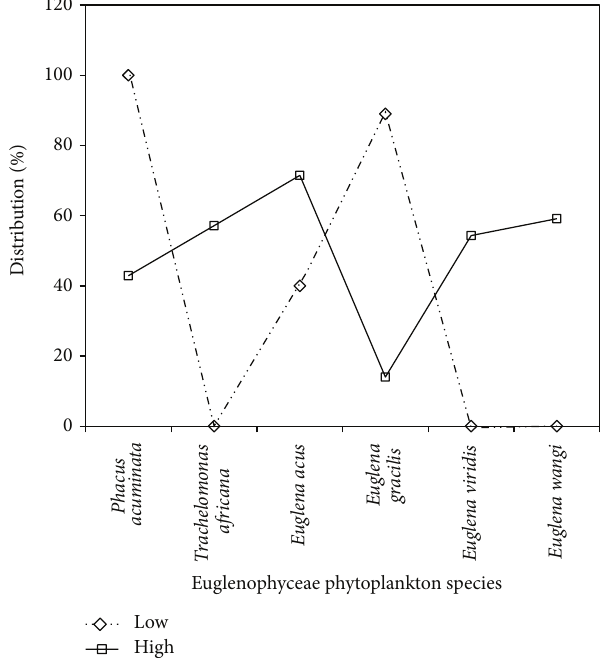
Figure 11: Variations of Euglenophyceae species in relation to tide in Okpoka Creek.